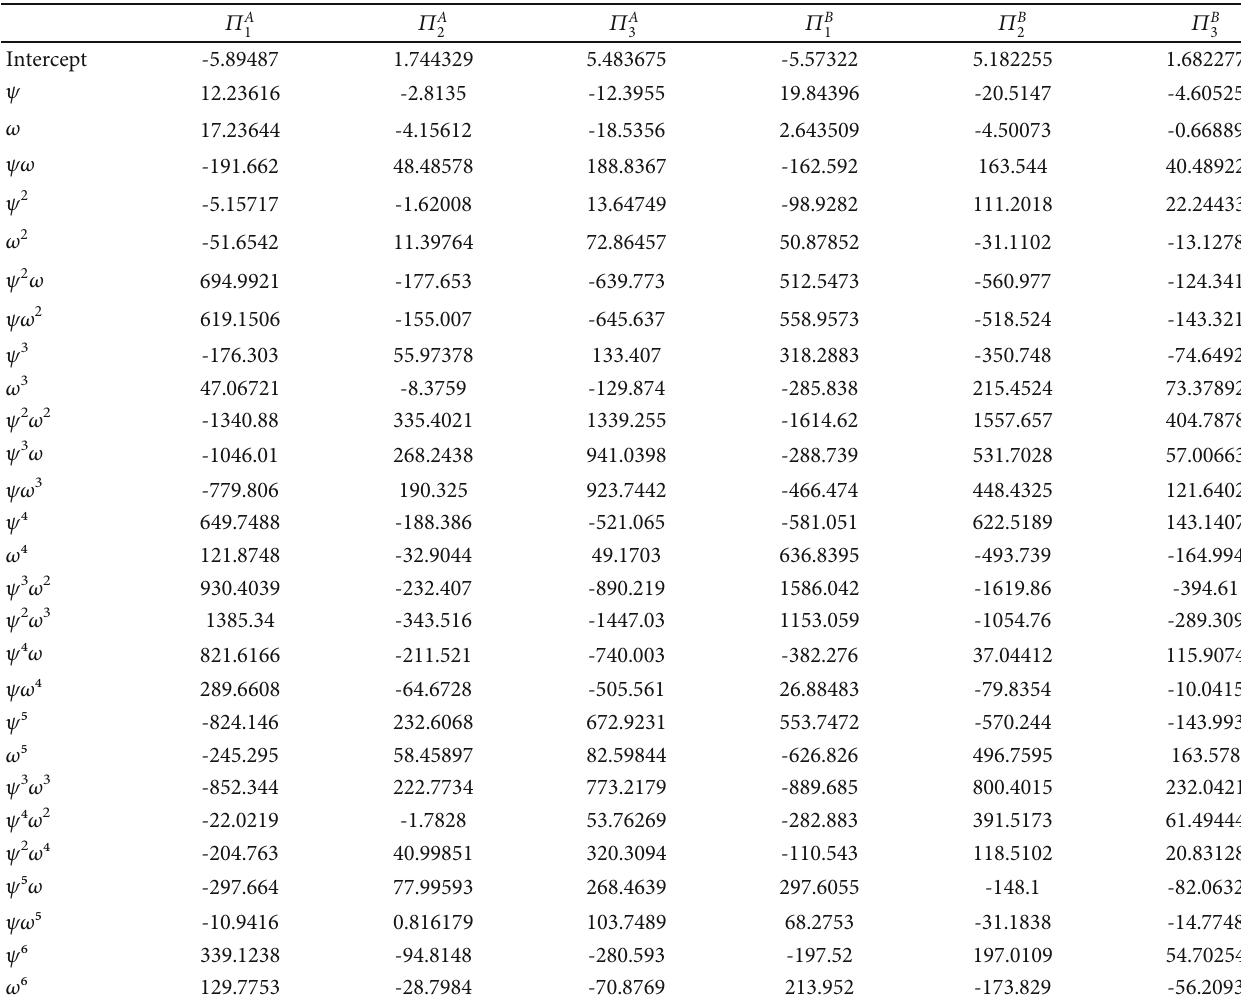
Table 3: Coe ffi cients of corner